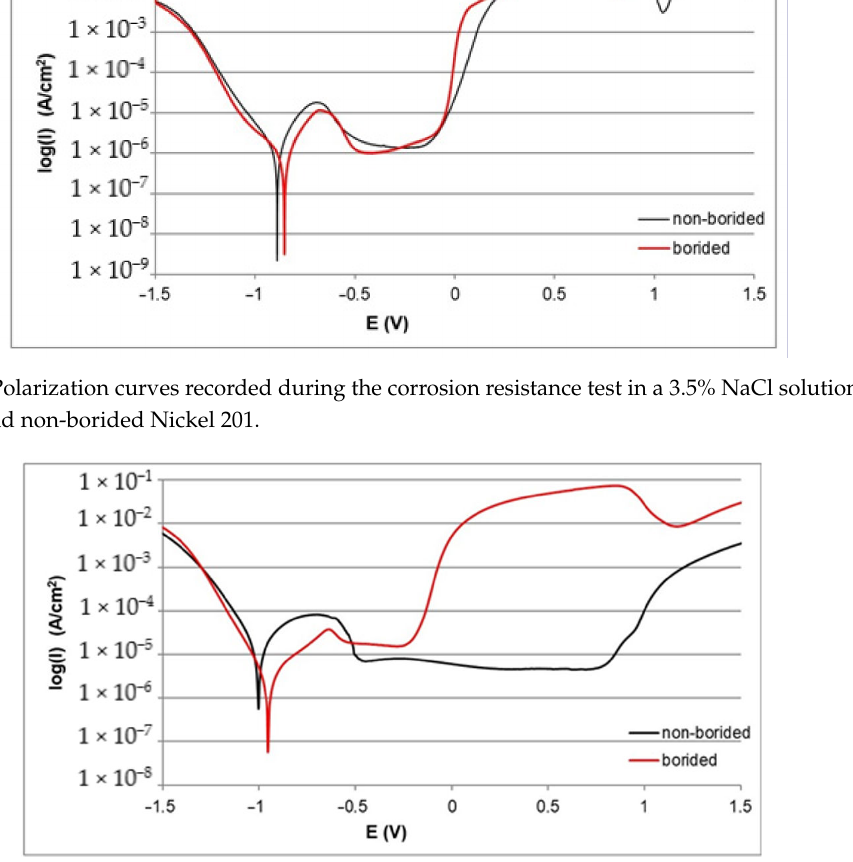
Figure 5. Polarization curves recorded during the corrosion resistance test in a 3.5% NaCl solution for borided and non-borided Inconel ® 600